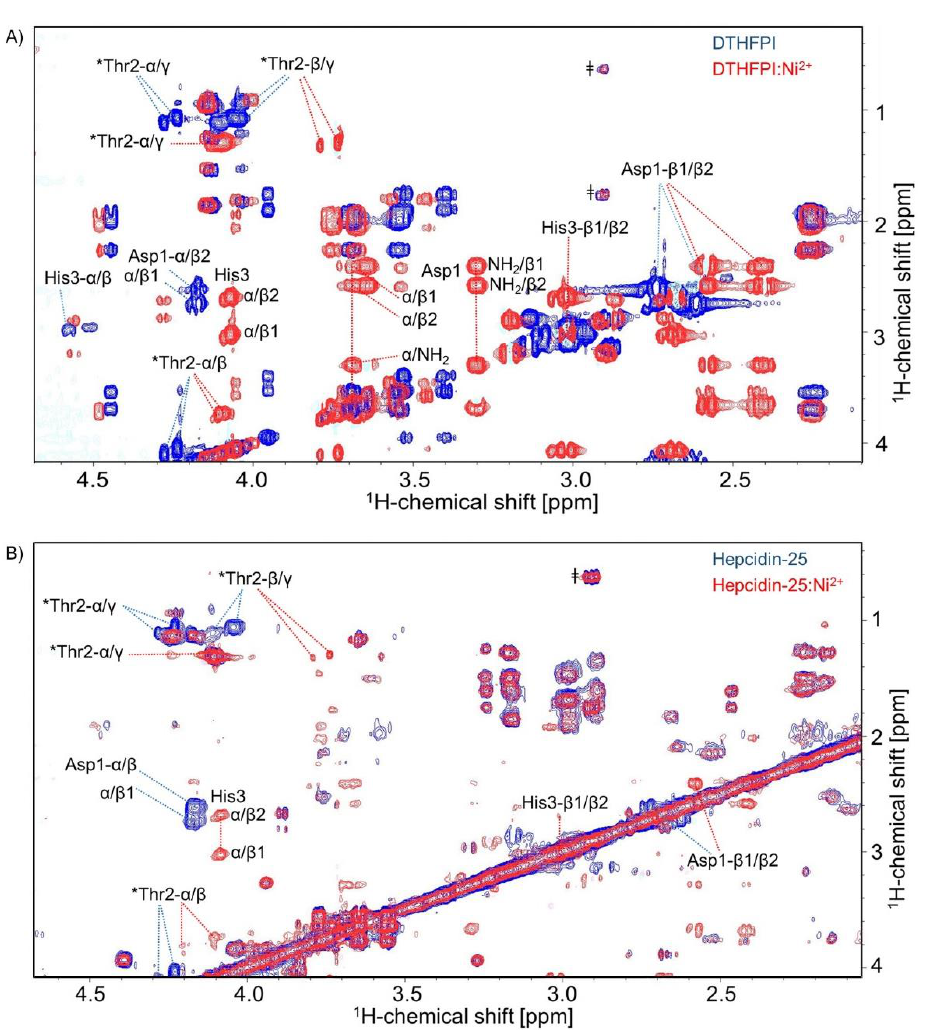
Figure 4. 1 H- 1 H Total Correlation Spectroscopy (TOCSY) spectra of ( A ) hexapeptide DTHFPI and ( B ) hepcidin-25 in the presence of Ni 2+ (red) and in the absence of Ni 2+ (blue). The most strongly affected amino acids in both cases are those of the ATCUN motif aspartic acid (Asp-1) (side-chain protons (H β )), threonine (Thr2) (alpha proton (H α ) and side-chain protons (H β and H γ ) shift) and histidine (His3). * Contains a double set of peaks for each amino acid and suggests the presence of cis -trans proline isomerization [11]. ǂ Indicates the presence of impurities.